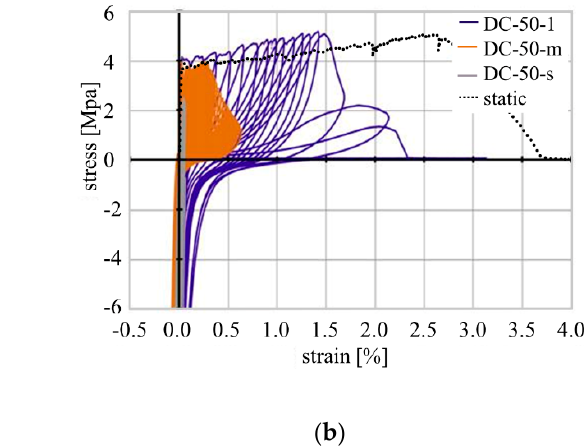
Figure 6. Representative stress-strain curves measured in deformation-controlled cyclic tests compared to a typical quasi- static test: ( a ) pure tension; ( b ) alternating tension-compression with lower reversal point at 50% of the compressive